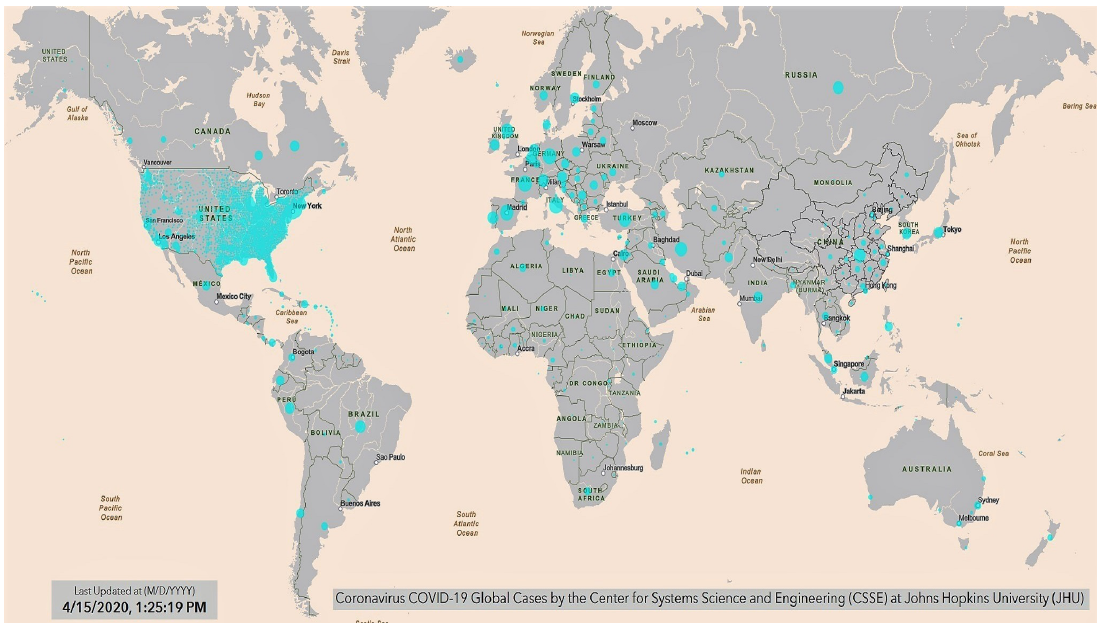
Figure 1. Geographical world distribution of the Coronavirus disease (COVID)-19